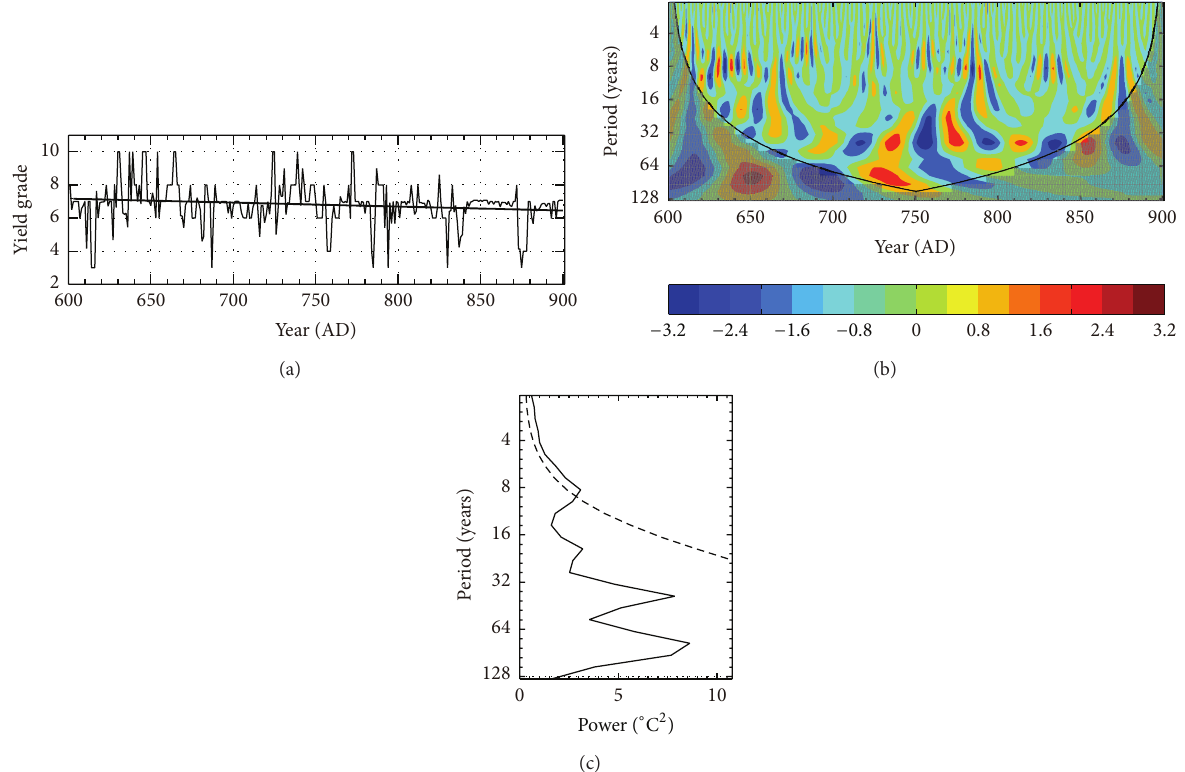
Figure 2: (a) Annual crop yield of North China from 601 to 900 AD (The straight line represents the negative trend of crop yield) and (b) real part-time frequency distribution of Morlet wavelet transform (shading denotes insignificance at confidence level of 95%) and (c) global power spectrum (dashed line denotes threshold value at confidence level of 95%).